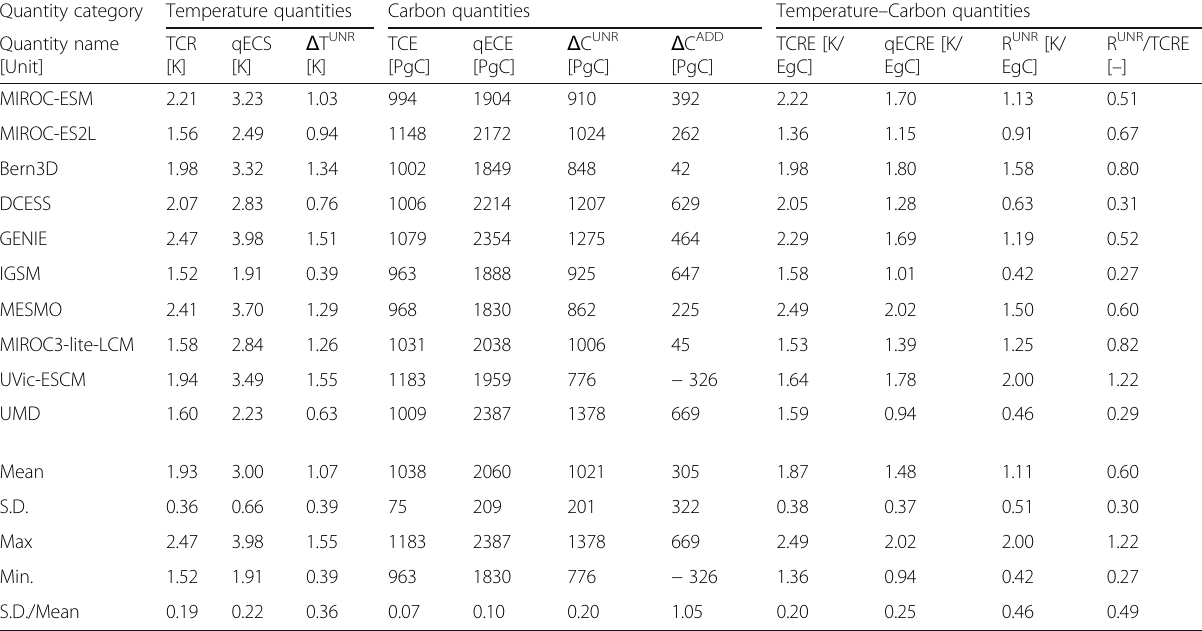
Table 3 Comparison of temperature, carbon, and temperature-carbon quantities in two Earth system models and eight Earth systems Models of Intermediate